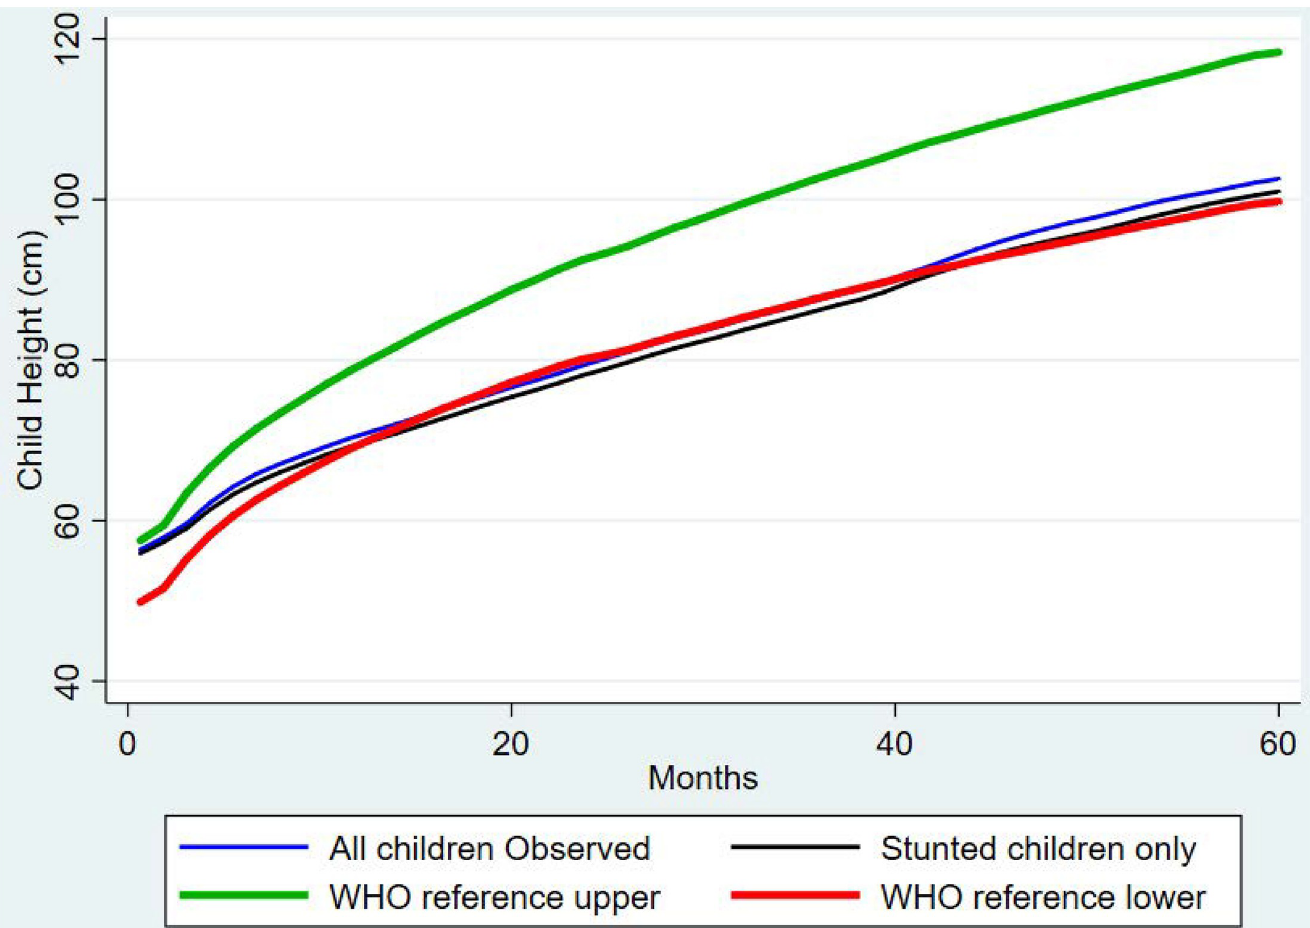
Fig 1. Child length/height (cm) for all children, stunted children only and WHO references by age (months).